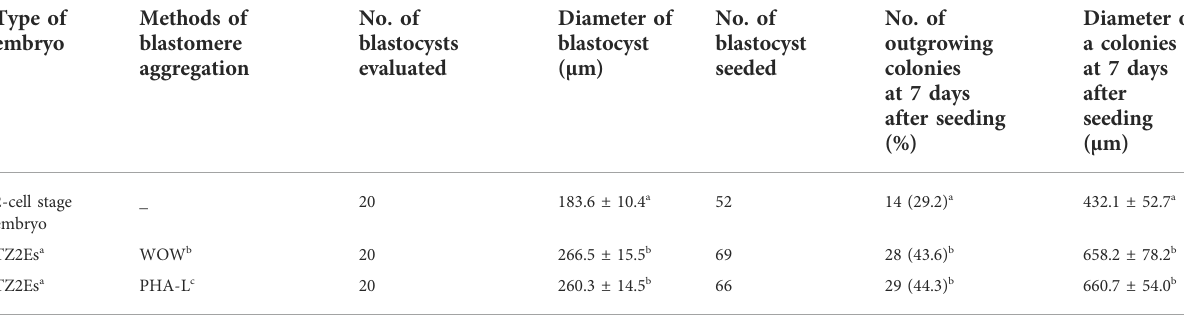
TABLE6Effects ofPhytohemagglutinin (PHA-L) ondiameter ofblastocystandoutgrowthofcoloniesfromblastocyst ofparthenogeneticembryosin pigs. Type of